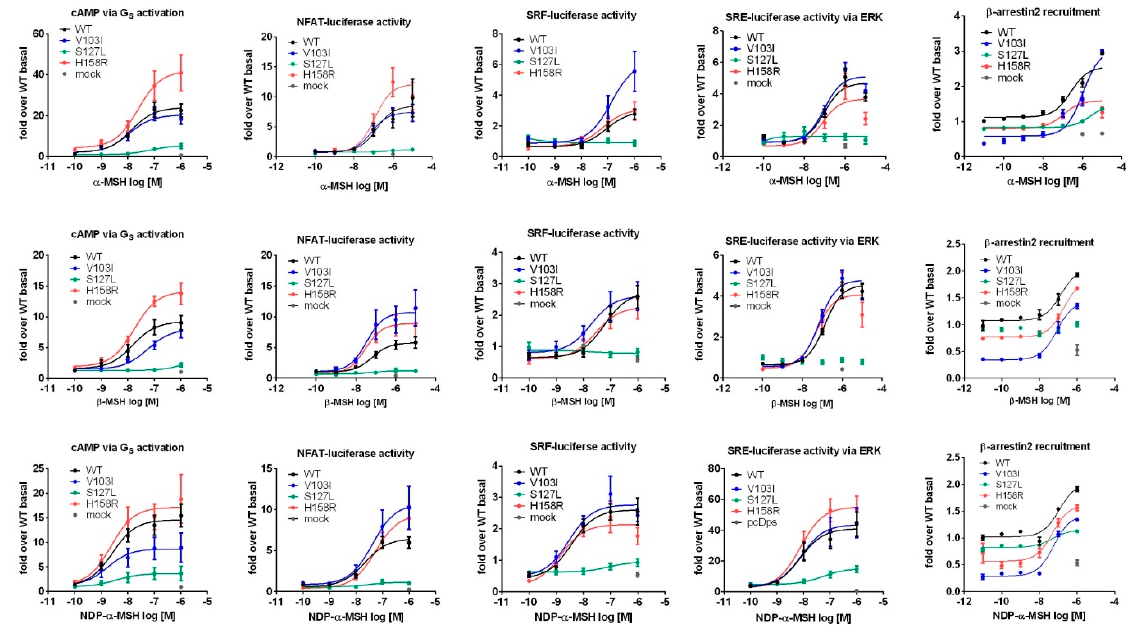
Figure 3. Concentration–response curves of all tested pathways were used to determine the potency (EC 50 ) as well as the efficacy (E max ) of each MC4R mutation in the respective pathway. All values were normalized to MC4R WT basal. The datasets contain pooled data from three to seven independent experiments each performed in triplicates. All concentration–response curves were analyzed with GraphPad Prism 6.0 using the non-linear regression model (sigmoidal response).